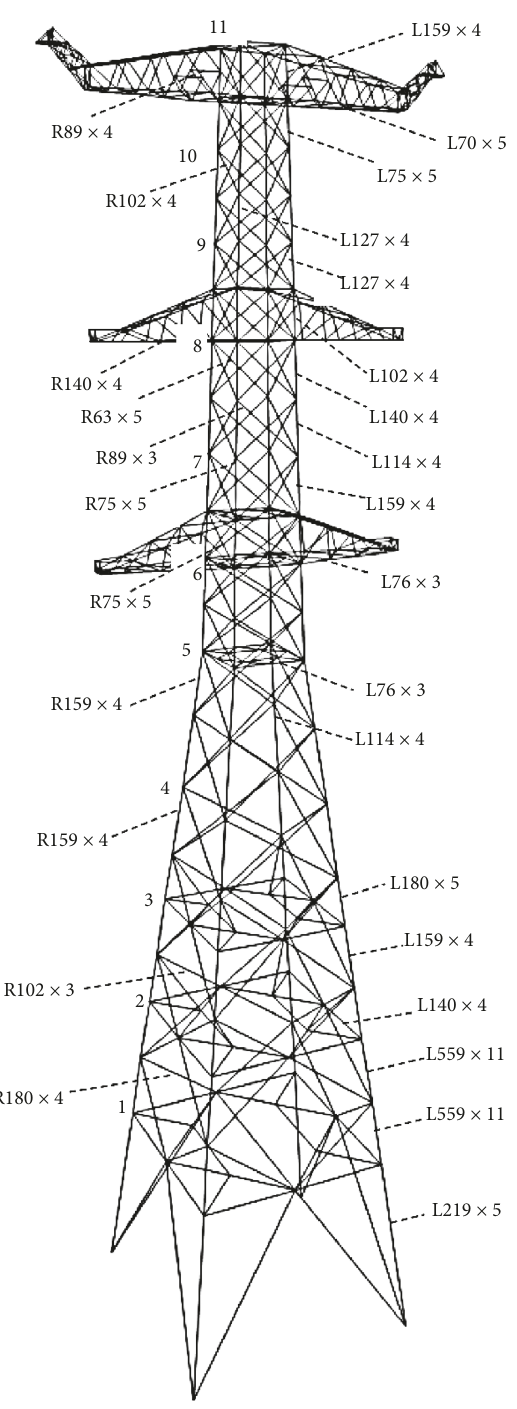
Figure 2: The finite element model of the SZ27104J linear tower and the dimensioning of its